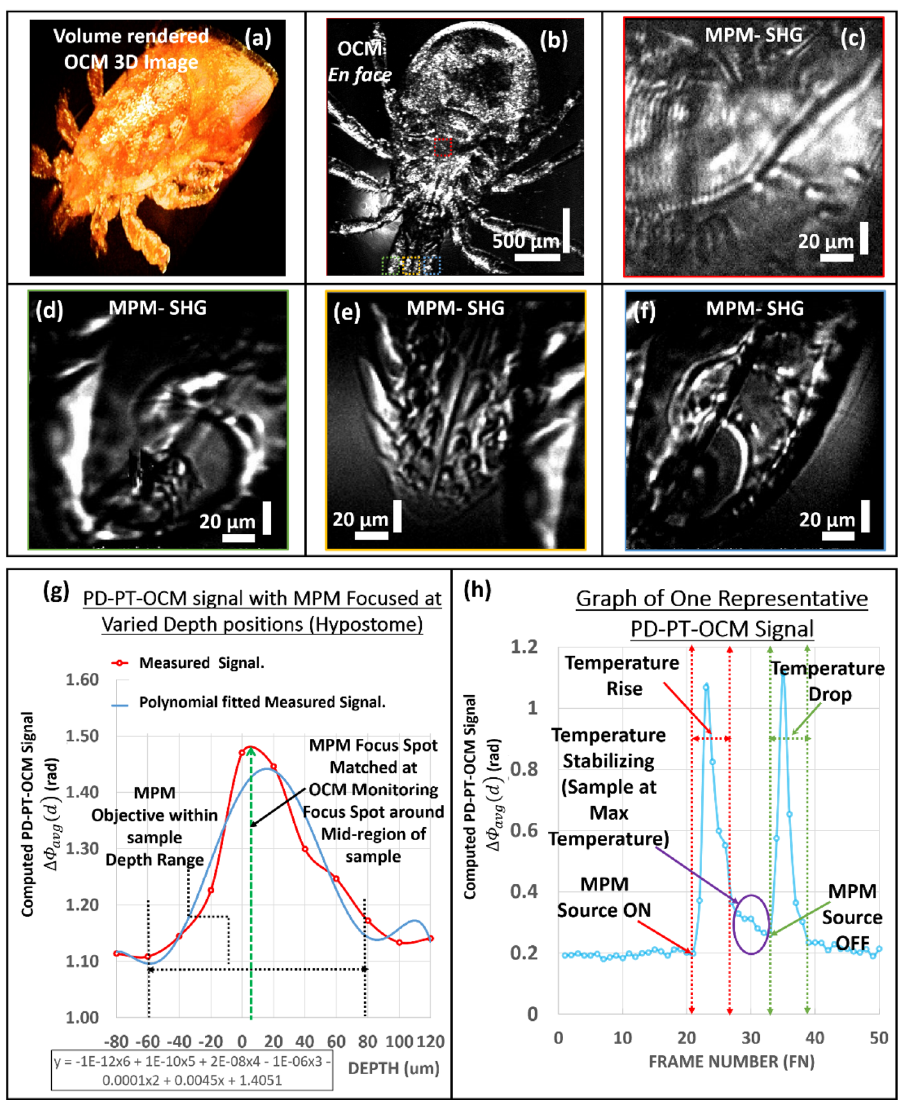
Figure 5. Verification of applicability of the proposed PD–PT OCM-guided MPM for a biological sample. ( a , b ) are the respective OCM volume-rendered image and en face image of the insect sample. Figures ( c to f ) are the MPM en face images of different regions in the sample obtained using the PD–PT OCM guidance. ( g ) is the representative photothermal response observed by varying depth position of MPM objective in the hypostome region of the sample, and ( h ) is the representative graph of one PD–PT OCM photothermal response